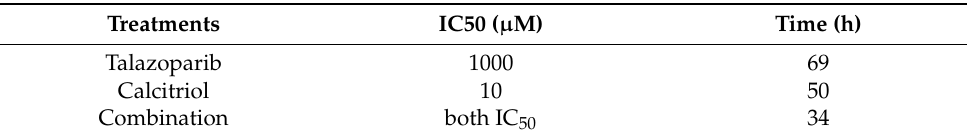
Table 1. The IC 50 concentrations on the BT − 20 cell line and the relevant time points.